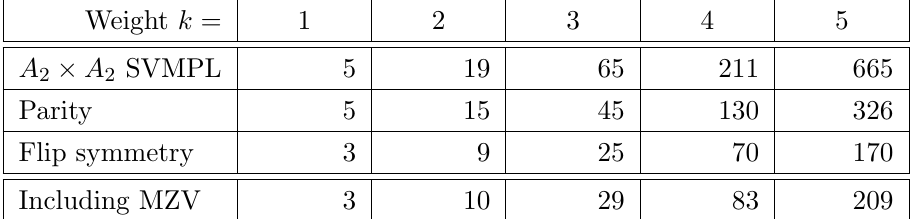
Table 1 . Dimensionality of basis of SVMPL relevant for seven-particle scattering in MRK, sequen- tially reduced by imposing the discrete symmetries of the MHV remainder